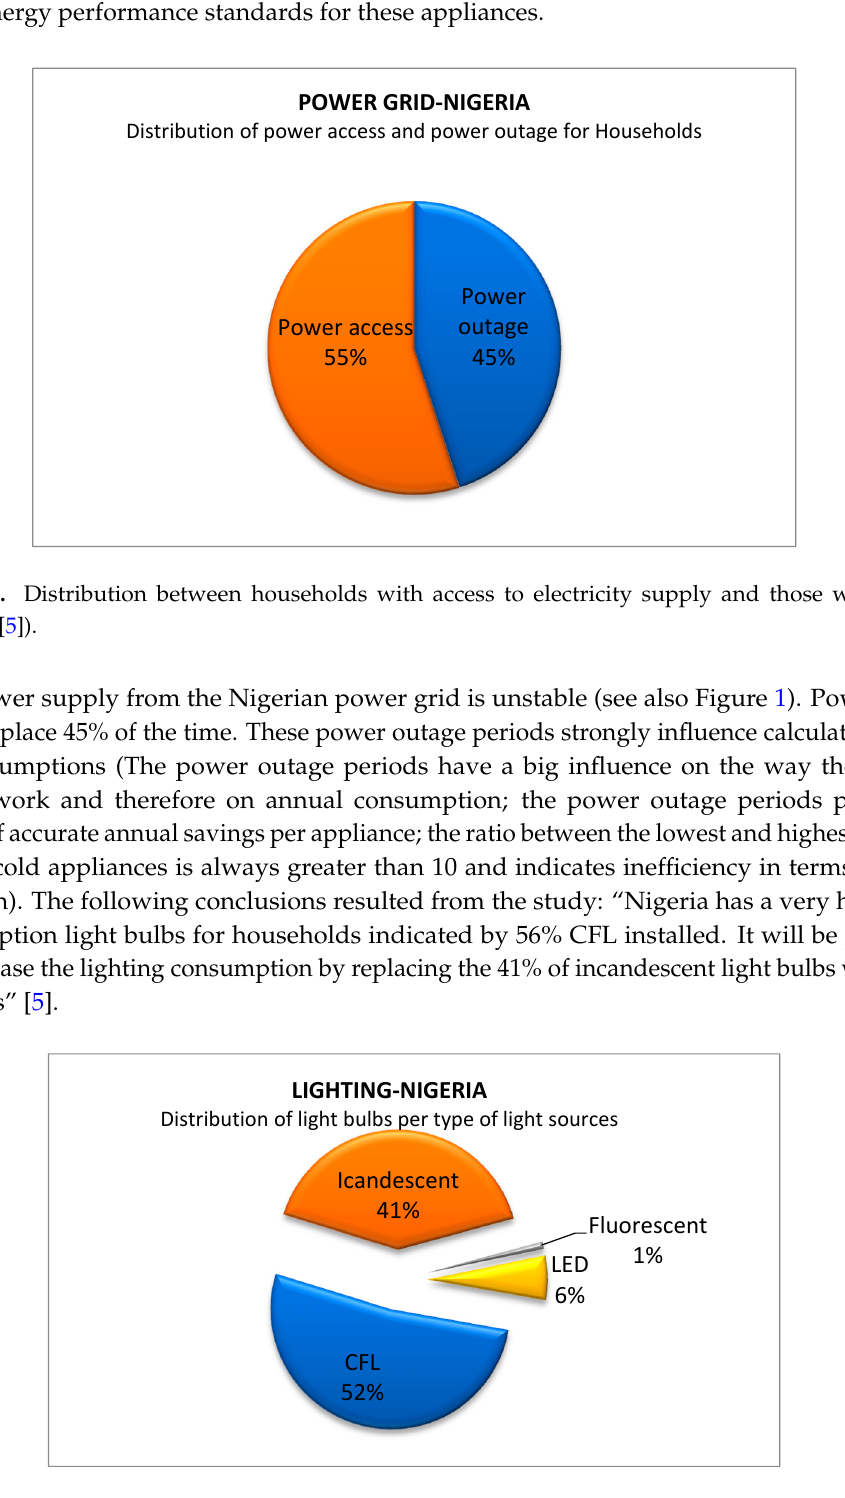
Figure 2. Distribution of light bulbs per type of light source (Source: [5]).